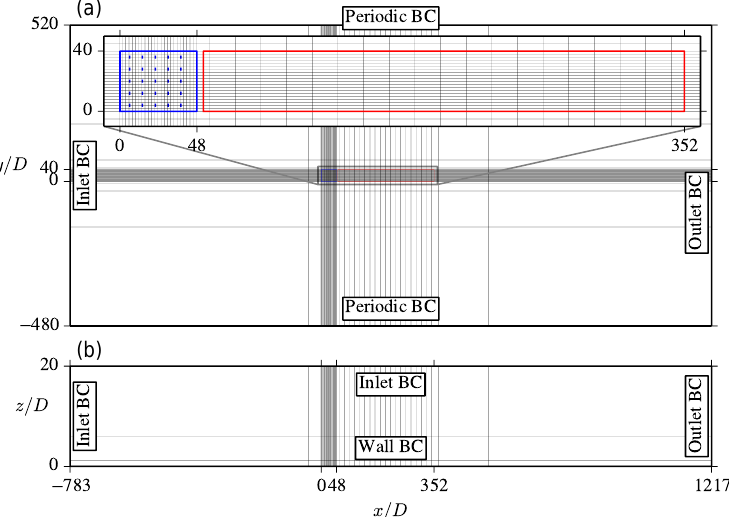
Figure 2. Grid and boundary conditions of wind farm simulations. Every 16th grid line is plotted. (a) Top view of the grid, including a zoomed view. (b) Side view of the grid. Blue filled boxes represent ADs. Spacing inside the blue and red rectangles are set to D/ 8 and D , respectively.